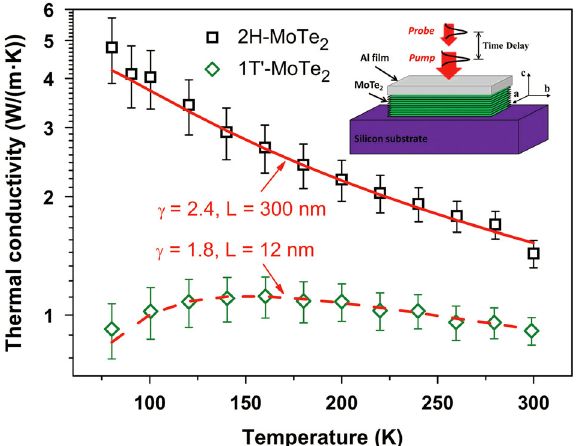
Fig. 2 Thermal conductivity of 2H-MoTe 2 and 1 T ’ -MoTe 2 samples in c -axis measured at 80 – 300 K. Error bars represent the systematic errors that are propagated from the uncertainties in fi lm thickness, laser spot size, and speci fi c heat of each layer, etc. The calculated results by our theoretical model are plotted as the solid and dashed red lines for the two samples, respectively. Inset: the schematic of TDTR measurements for the bulk MoTe 2 sample in this